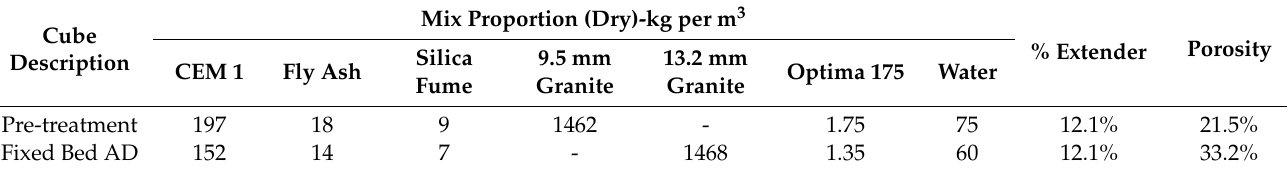
Table 3. Pervious concrete mix designs and